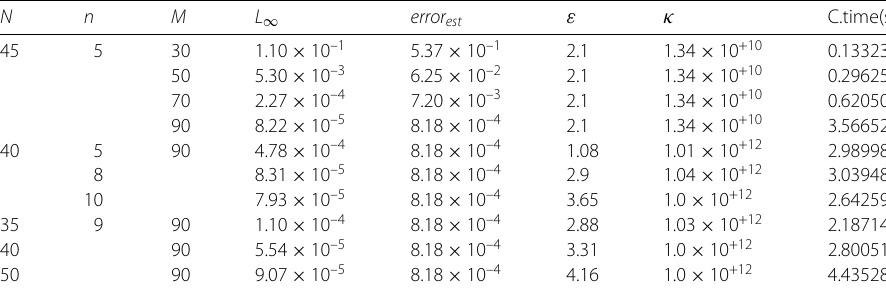
Table 2 The results are obtained for α = 0.3321, x ∈ [0,1], and t = 1